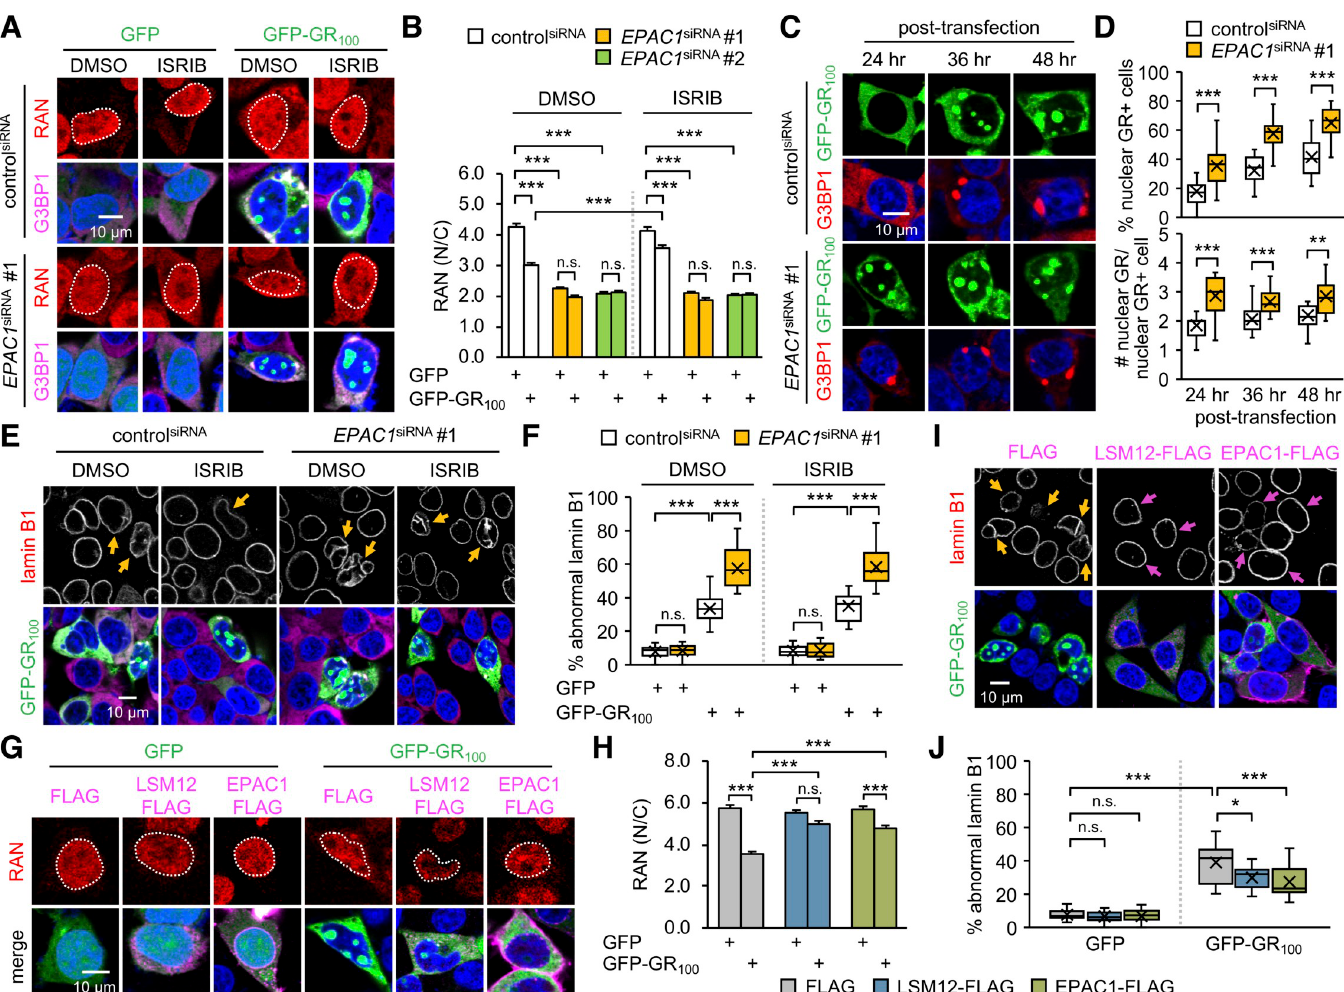
Fig 6. EPAC1 suppresses poly(GR) toxicity relevant to NCT and nuclear integrity. (A) SH-SY5Y cells were transfected with control siRNA or EPAC1 siRNA 24 hours before transfecting with an expression vector for GFP or GFP-GR 100 . Transfected cells were co-stained with anti-RAN antibody (red), anti-G3BP1 antibody (magenta), and Hoechst 33258 (blue) 72 hours after siRNA transfection. Where indicated, cells were treated with 2- μ M ISRIB or DMSO (vehicle control) for 5 hours before antibody staining. (B) The nucleocytoplasmic RAN gradient was quantified as in Fig 2D. Two-way ANOVA detected significant interaction effects of GFP-GR 100 and ISRIB treatment on the RAN gradient in control siRNA cells ( P = 0.0008), but not in EPAC1 siRNA cells ( P = 0.4674 for EPAC1 siRNA #1; P = 0.7870 for EPAC1 siRNA #2); significant interaction effects of GFP-GR 100 and EPAC1 depletion on the RAN gradient regardless of ISRIB treatment ( P < 0.0001 for both EPAC1 siRNA in DMSO; P = 0.0327